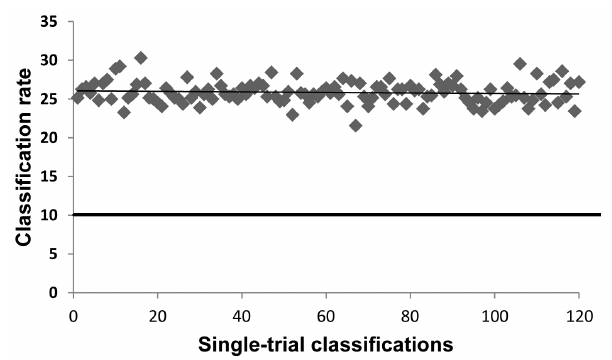
Figure 12. Single-trial classification rates over 120 trials for the set of words { London, Moscow, Paris, north, south, east, west, Germany,Poland,Russia }. 640 samples (S18) classified into 10 classes. Chance accuracy is shown by the thick solid line.